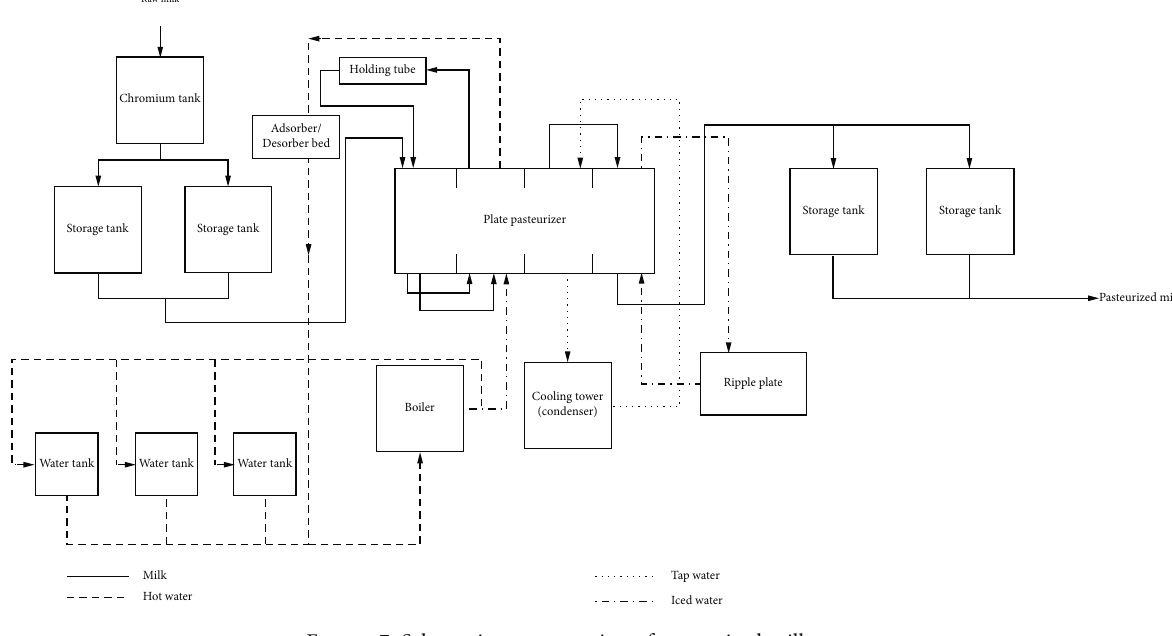
Figure 7: Schematic representation of pasteurized milk process.